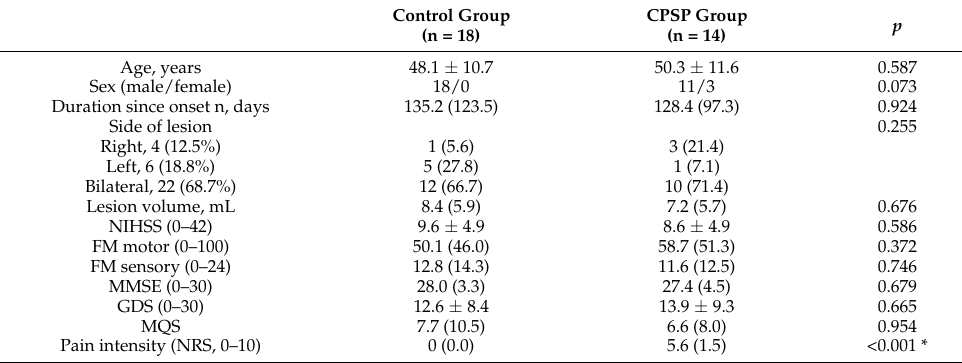
Figure 1. Flowchart of patient enrollment. MRI, magnetic resonance imaging; CT, computed tomography; K-MMSE, Korean Mini-Mental State Examination; 18 F-FDG-PET, 18 F-fluorodeoxyglucose- positron emission tomography; CPSP, central post-stroke pain. Table 1. Demographic characteristics of patients with pontine